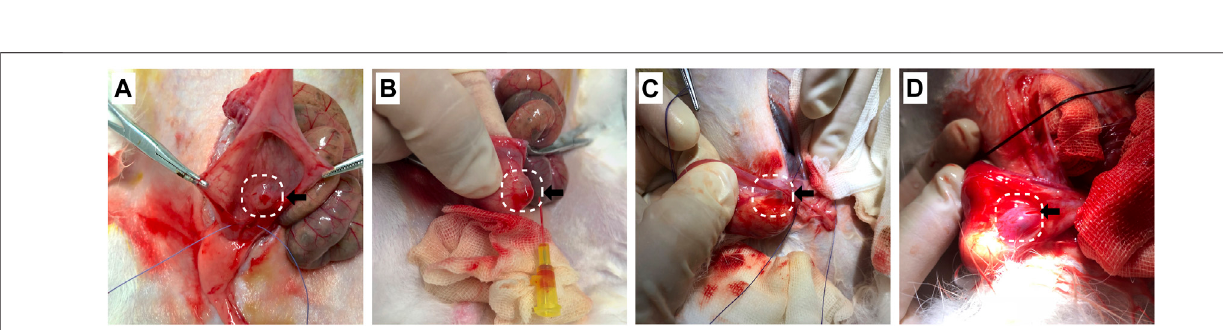
TABLE 6 | Treatment results of the VUR rabbits after 4 weeks of the injection. Group Rabbit No. Survival VUR grade Bulking agent